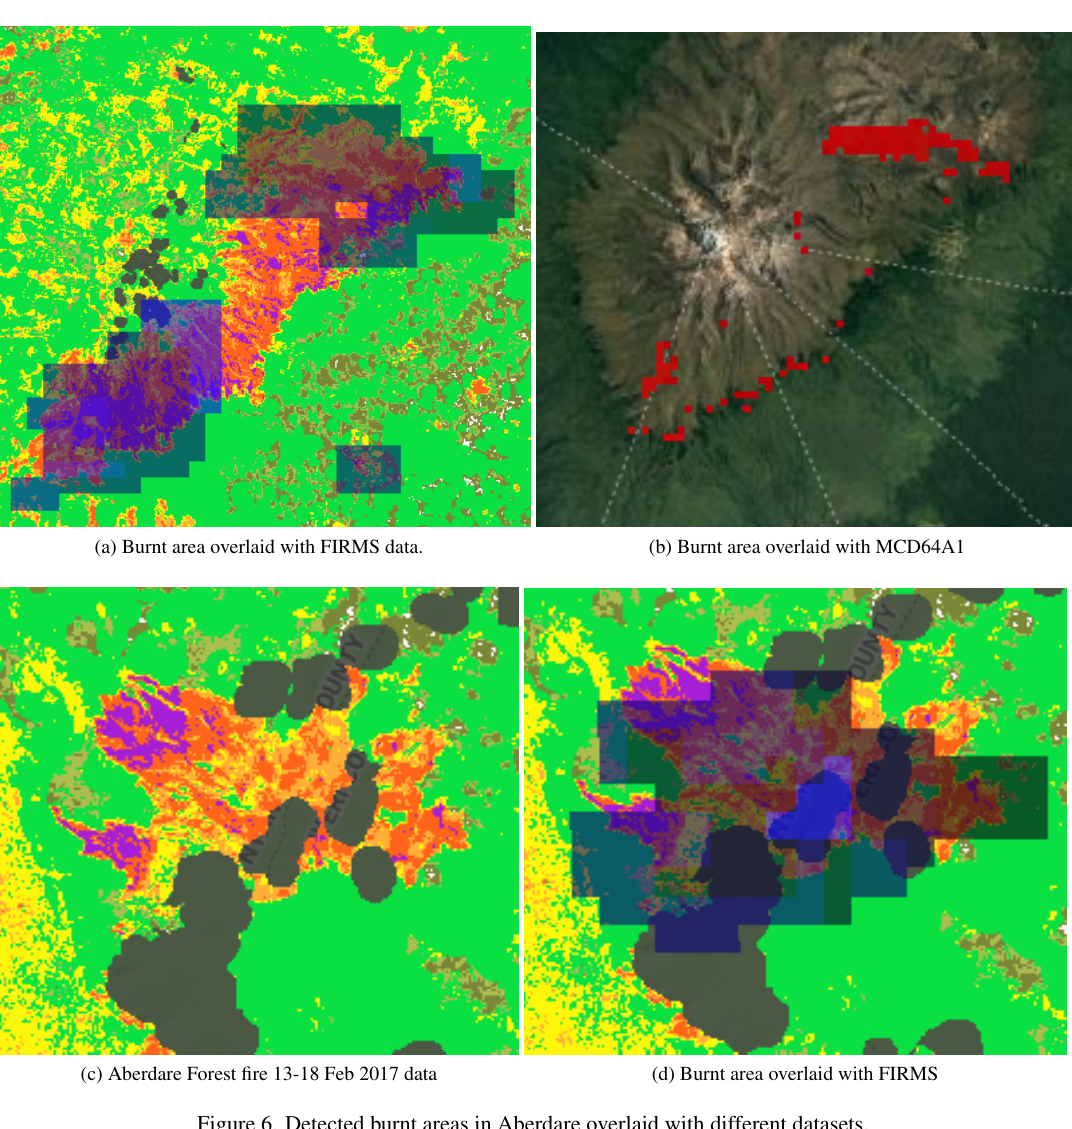
Figure 6. Detected burnt areas in Aberdare overlaid with different datasets.